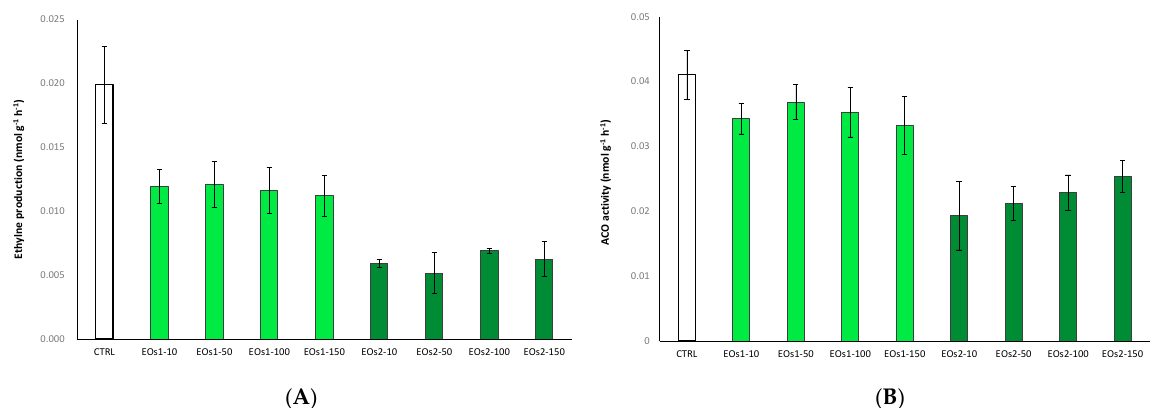
Figure 9. Ethylene production ( A ) and 1-aminocyclopropanecarboxylic acid oxidase activity (ACO) ( B ) of broccoli florets with active paper sheets including two different EOs mixes ( EOs1 , car- vacrol:spearmint EOs 80:20; or EOs2 , carvacrol:oregano EO:cinnamon EO 70:10:20) at different doses (0 (CTRL), 10, 50, 100, and 150 mg m − 2 ) at 2 ◦ C (mean ± SD) [44].